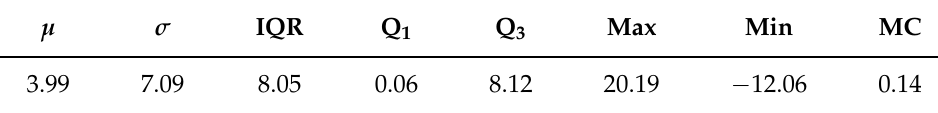
Figure 9. VSP box plot comparison between E7.8 and E10. Table 4. Statistical summary for tests performed using E7.8.